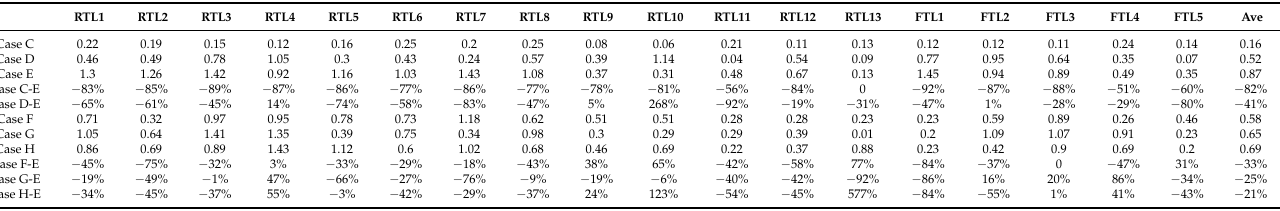
Table A3. Temperature increment at all test streets and average